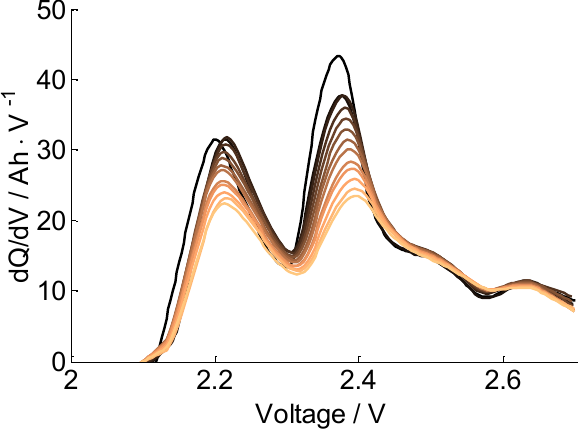
Figure 12. The IC curves of Cell C after every 90 cycles up to 1080 cycles; with cycle number increase, line color changes from black to tan.